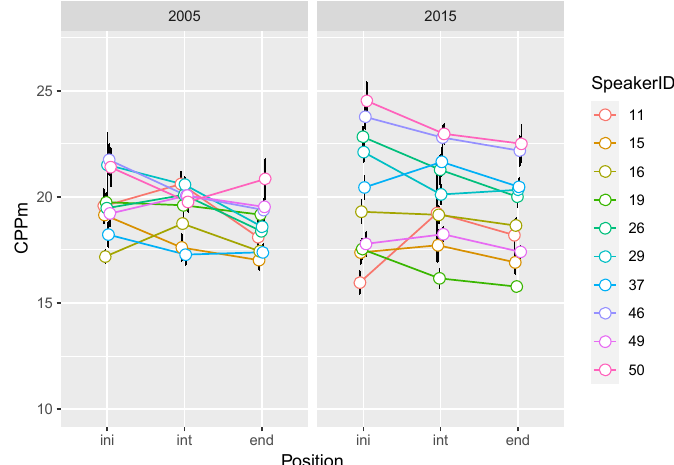
Figure A7. Speaker-specific data for HNR35Km.